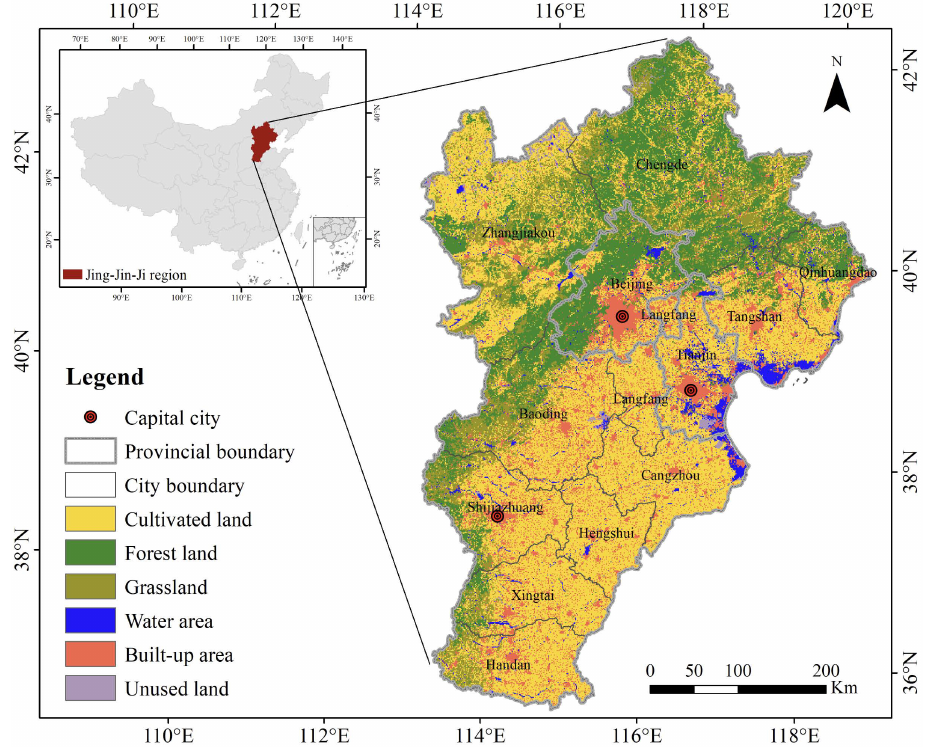
Figure 1. Location, land use and administrative division of the Beijing-Tianjin-Hebei Urban